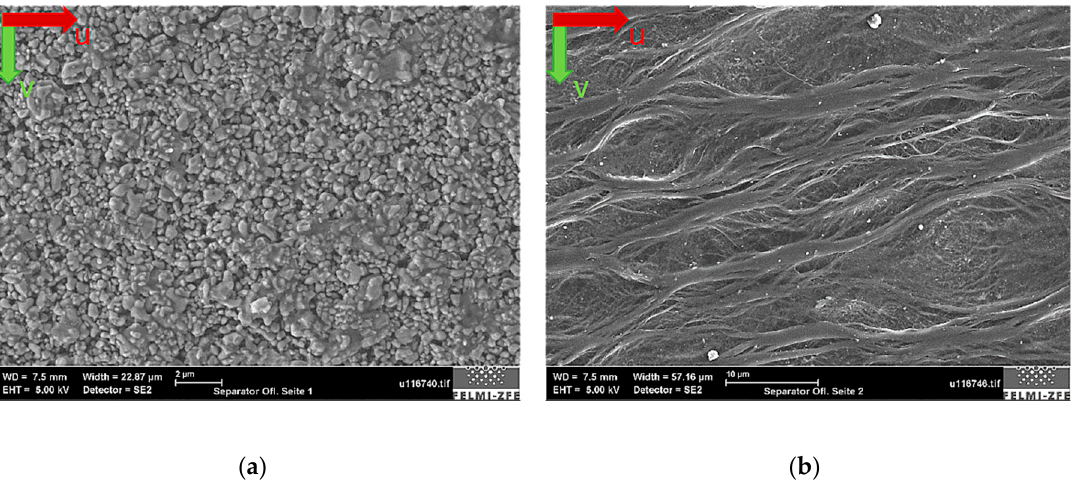
Figure 11. SEM images of the separator surface structure on both sides. To the left ( a ), an Al 2 O 3 (alumina) layer deposited on the membrane surface is visible. To the right ( b ), the fiber structure of the microporous membrane can be seen. Here, “u” and “v” denote the machine and the transversal directions of the battery and its layers.